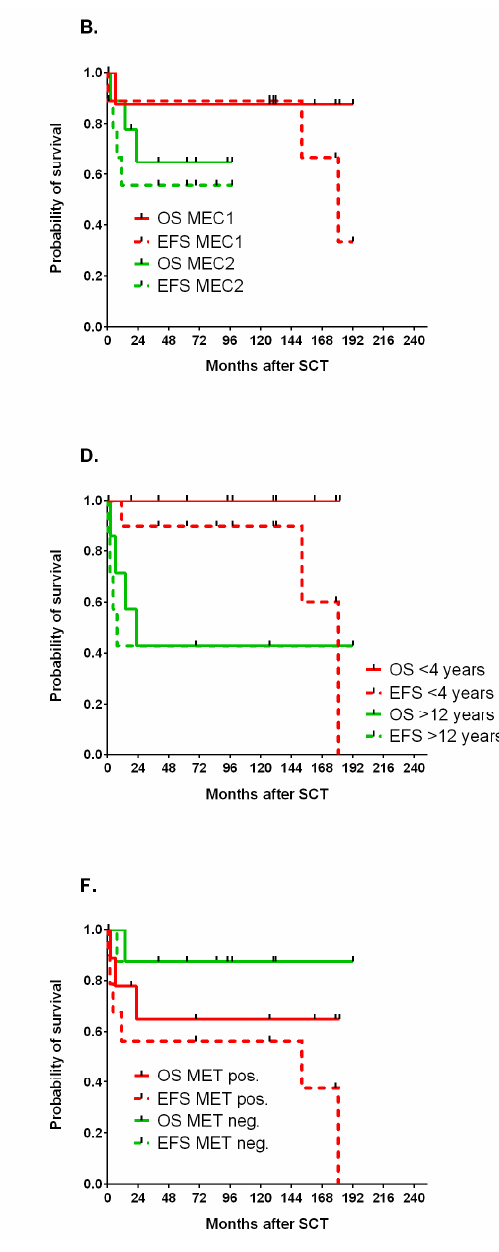
Figure 1. Probability of OS and EFS in the whole group. ( A ) In patients treated with MEC1 or MEC2 ( B ), male and female patients ( C ), children below the age of 4 years and above the age of 12 years ( D ), primary resistant or relapsing tumors ( E ), and in patients with disseminated disease (MET pos.) or a localized tumor (MET neg.) ( F ).